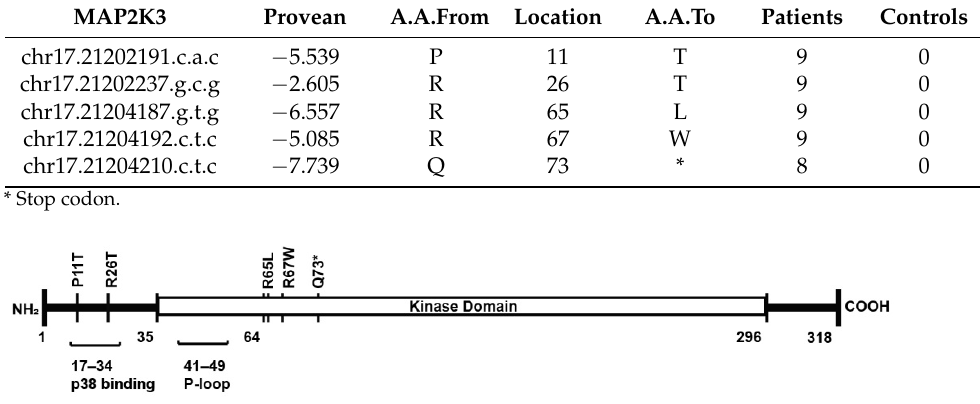
Figure 2. Linear representation of MEK3 indicating location of ALL mutations. Schematic diagram of MEK3 showing mutations identified from the ALL patient library. Amino acids are shown located within structural domains of MEK3.